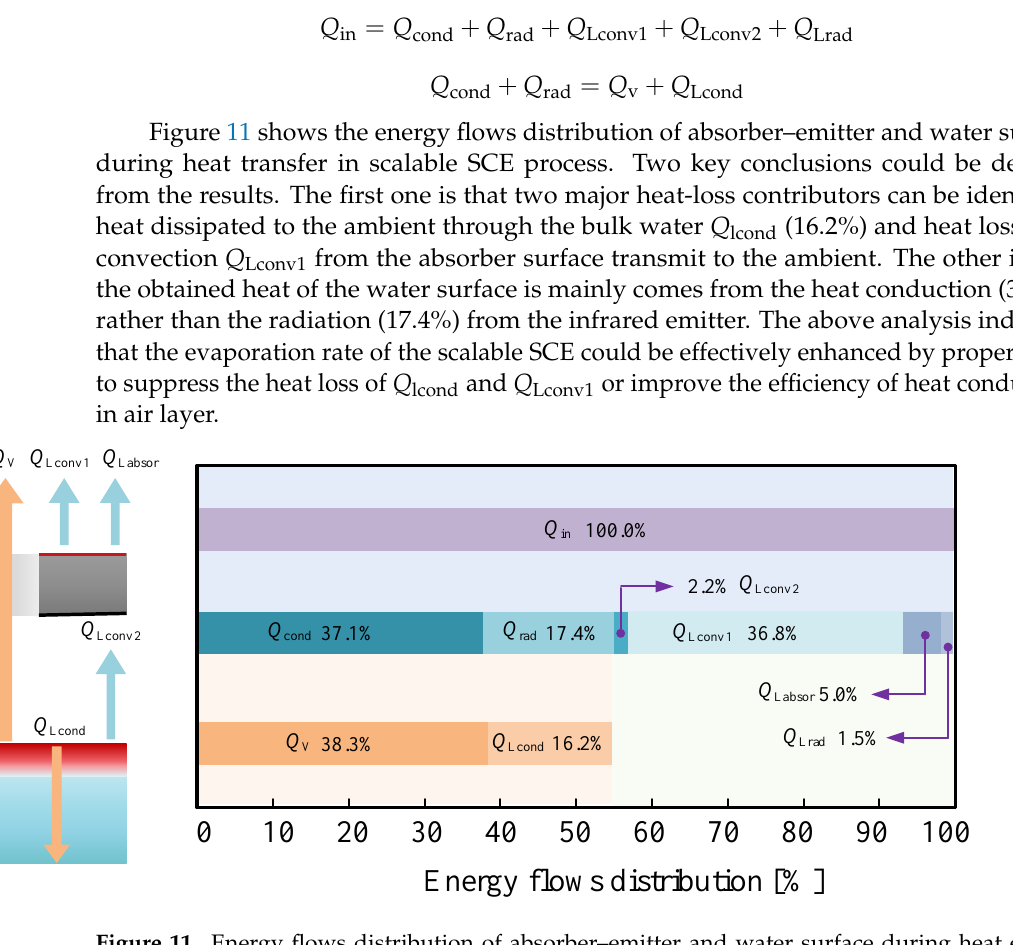
Figure 11. Energy flows distribution of absorber – emitter and water surface during heat energy transfer from the top to bottom under the condition that the thickness of air layer is 2 mm, the hole diameter is 1.1 mm, and the hole area ratio is 14%.